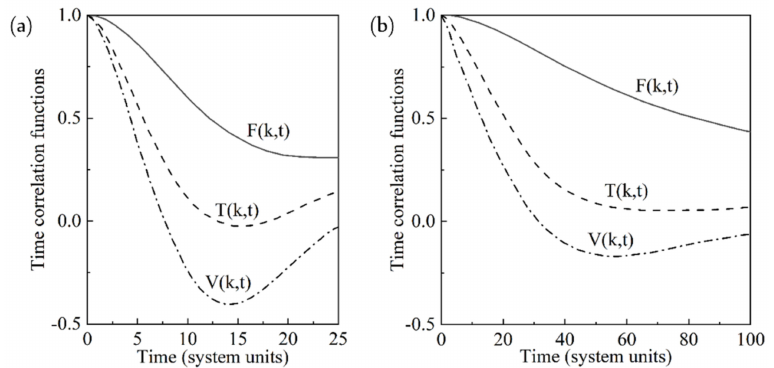
Figure 7. Molecular dynamics F ( k , t ), V ( k , t ), and T ( k , t ) functions for different densities, k = 0.32, T = 0.6 (K), ( a ) normal fluid case with n = 0.7, ( b ) supercritical fluid case with n = 0.34. (For in-depth interpretation of these data, the readers are referred to Luo et al. paper